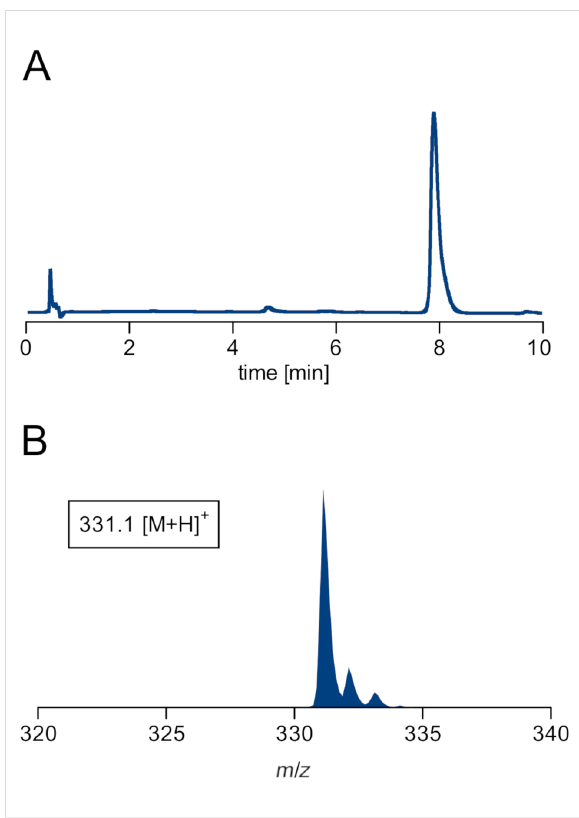
Figure 4: Analysis of mutasynthon 14 obtained via the convergent syn- thetic route by HPLC on a HILIC stationary phase and UV detection (A) and mass spectrometry